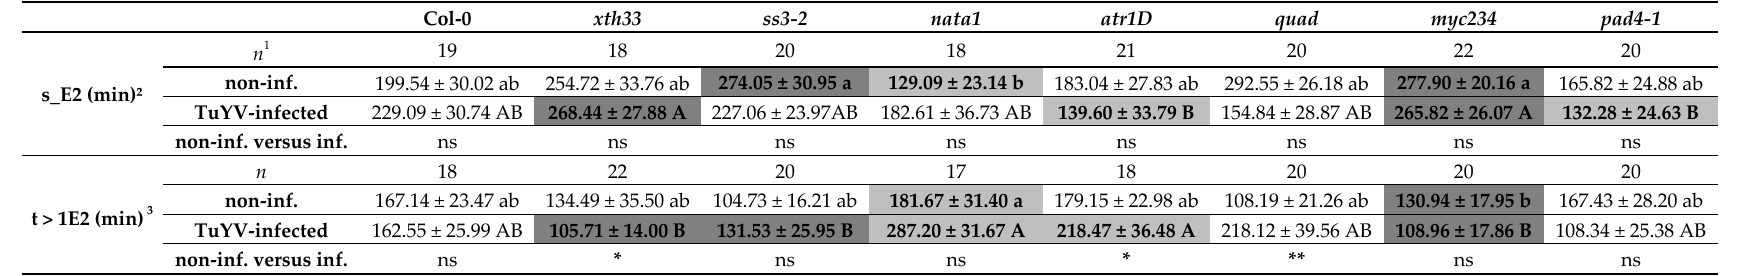
Table 3. Feeding behavior of M. persicae on non-infected and TuYV-infected A. thaliana mutants.